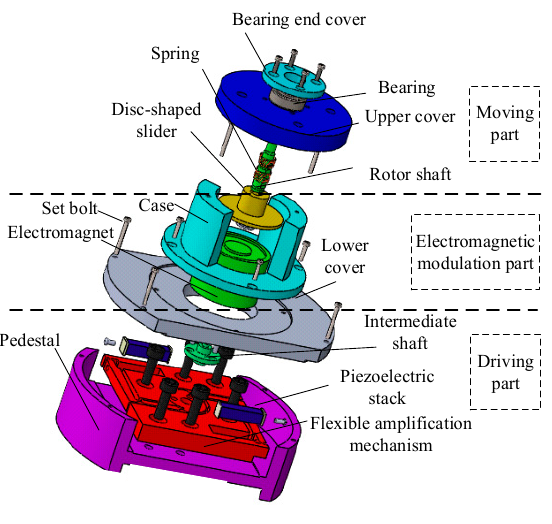
Figure 1. Motor structure.